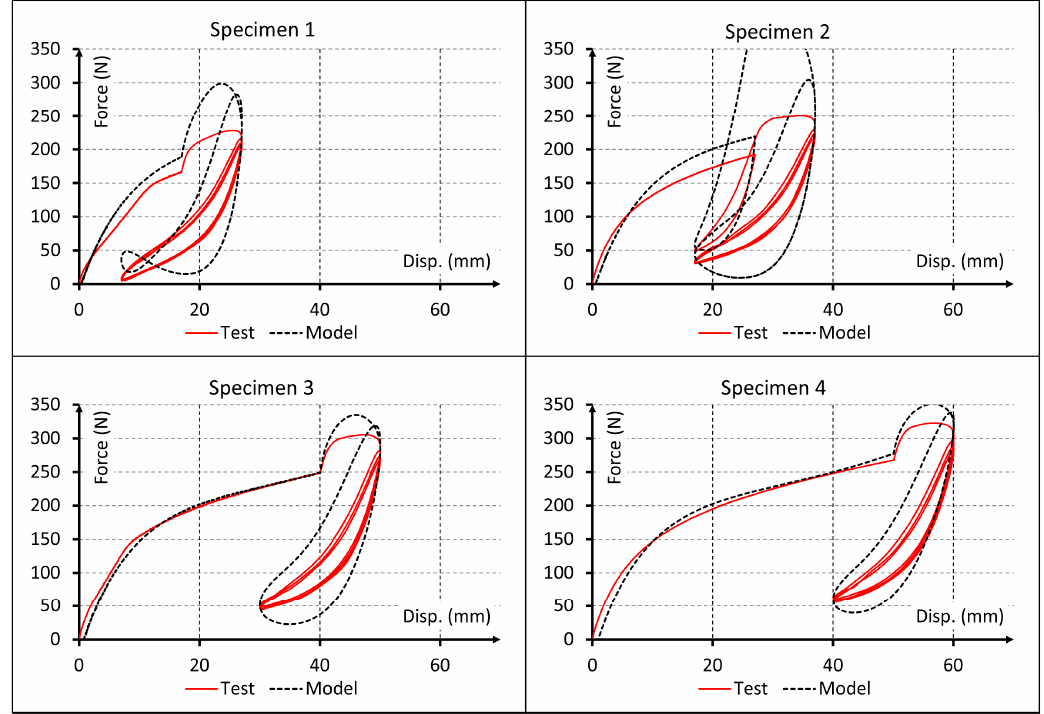
Figure 6. Comparison for first cycles between experimental data and force-displacement curves simulated using visco-hyperelastic model with Ogden-Roxburgh damage model.